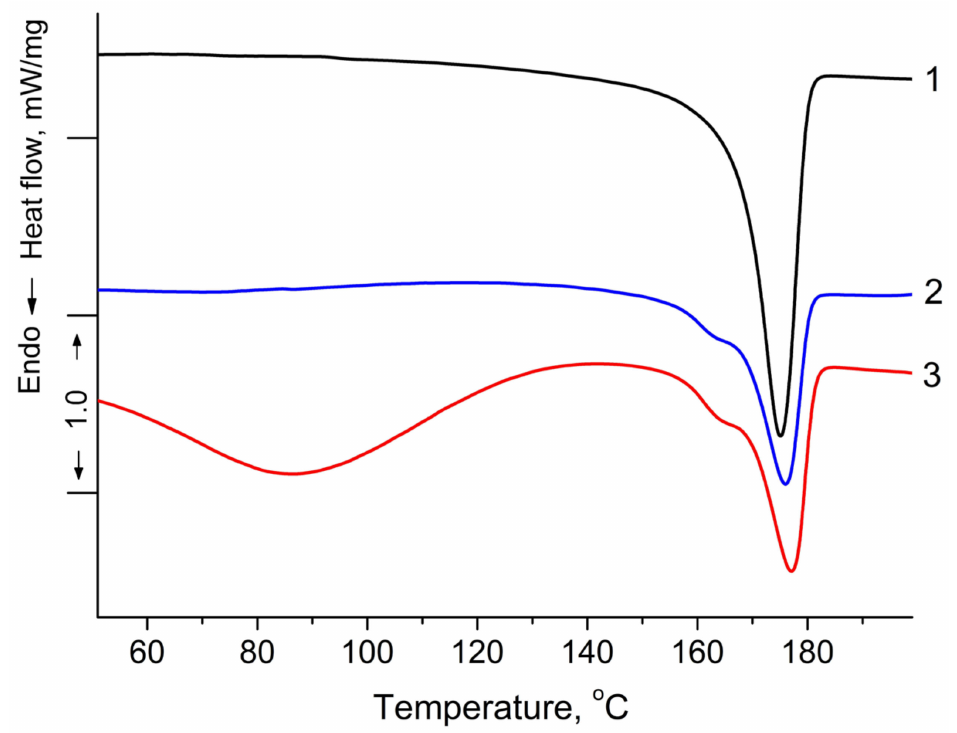
Figure 2. DSC heat flow curves of PHB (1), PHB–chitosan (50:50) wt. % (2) and PHB–chitosan (50:50) wt. % composition containing sorbed Fe 3+ ions